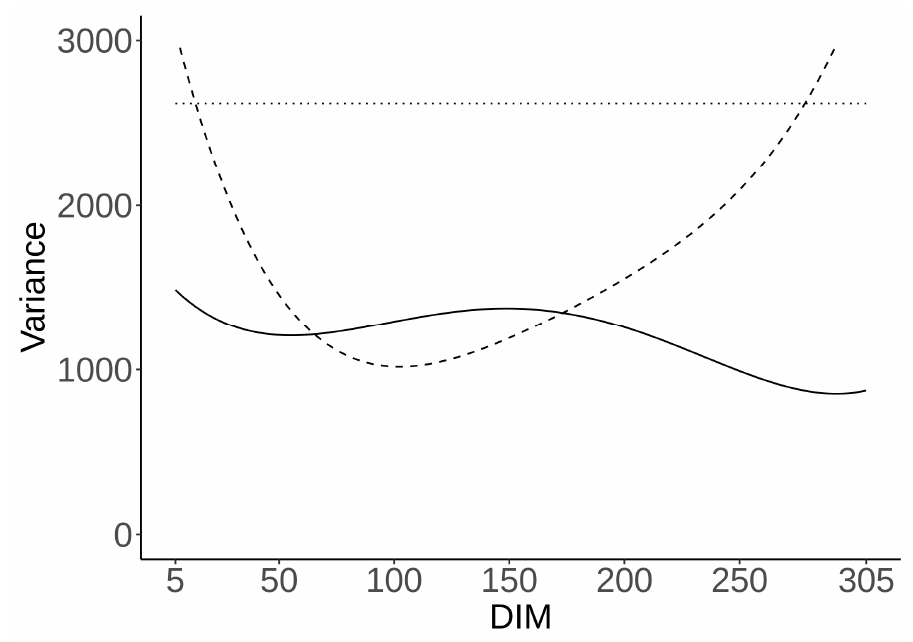
Figure 1. Residual (dotted line), permanent environment (dashed line), and genetic (solid line) var- iances (ppm/d) 2 throughout lactation for CH 4 ppm/d.